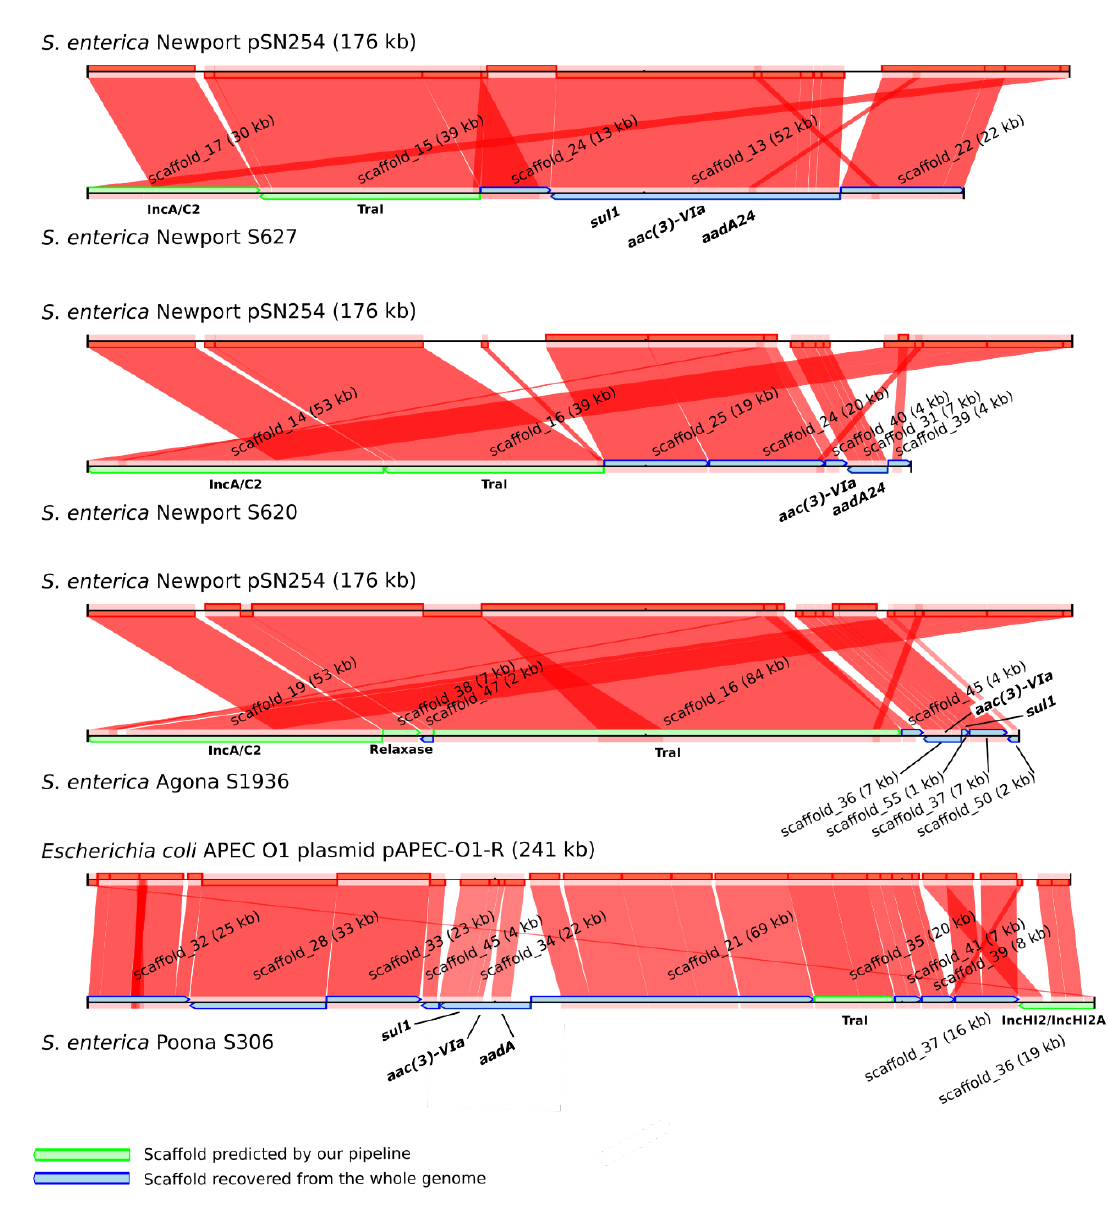
Figure 3. Recovery of plasmid fragments in whole genome sequencing (WGS) data based on comparisons with reference plasmids. The reference plasmids above each alignment were selected based on the best match against the National Center for Biotechnology Information (NCBI) Plasmid database with the sca ff old encoding aac(3)-VIa gene usually found in plasmid sequences. The WGS data were mapped using CONTIGuator v. 2.7 against the reference plasmids. Several sca ff olds without ORI or mobility protein have been identified as plasmid sca ff olds in the four Salmonella genomes using a reference